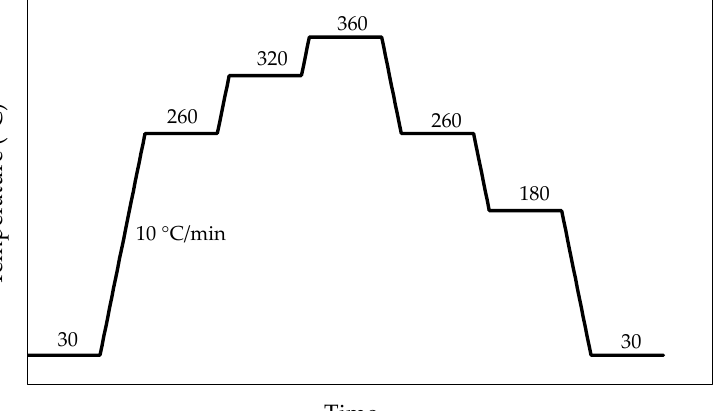
Figure 3. Thermal cycle of the samples in the thermo-diffractometer. Measurements were performed at the temperatures indicated in each step.